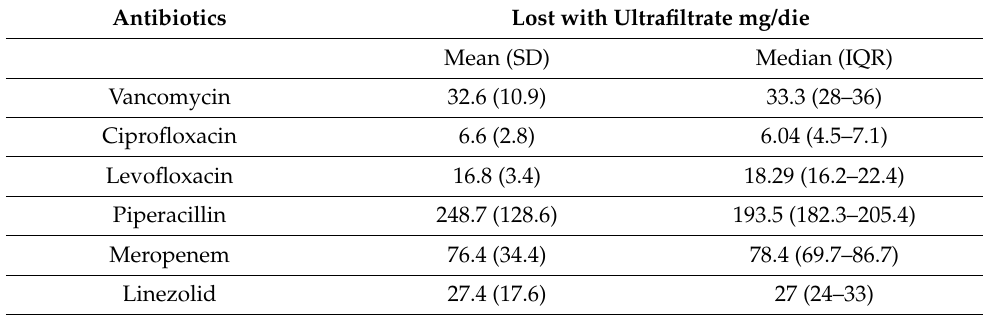
Table 4. Antibiotic concentration lost with